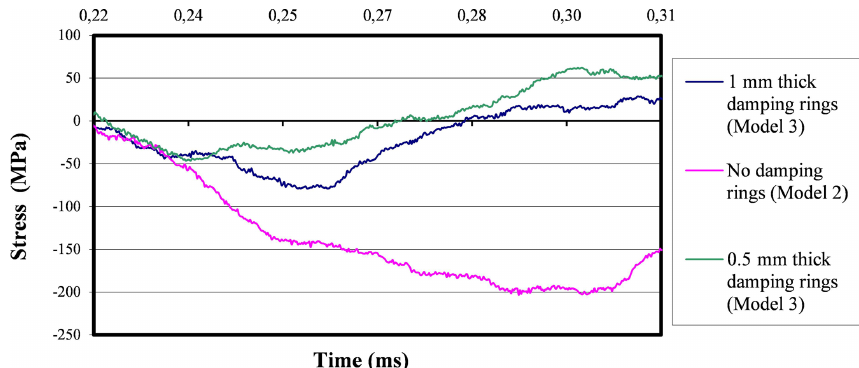
Figure 32. Reflected stress-time curves pertinent to the actual experiment at 3.5 bar when using 1mm thick, 0.5mm thick, and no damping rings.